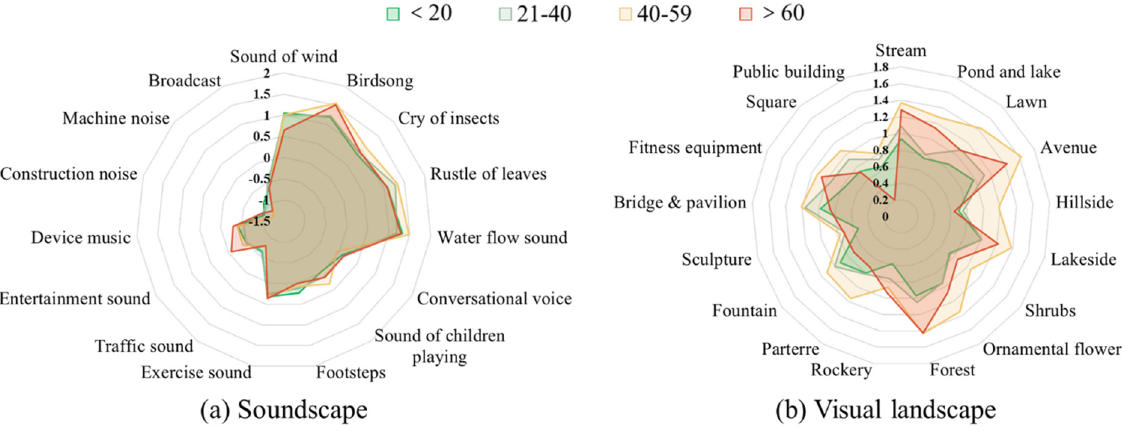
Figure 8. Radar map of soundscape ( a ) and visual landscape ( b ) preferences distribution of exercisers at different ages.